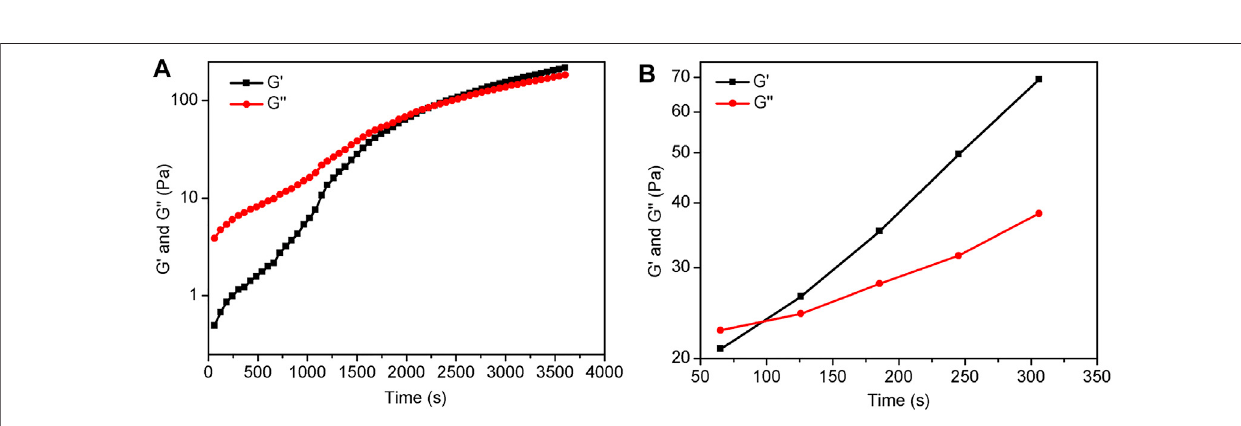
Frontiers in Chemistry |